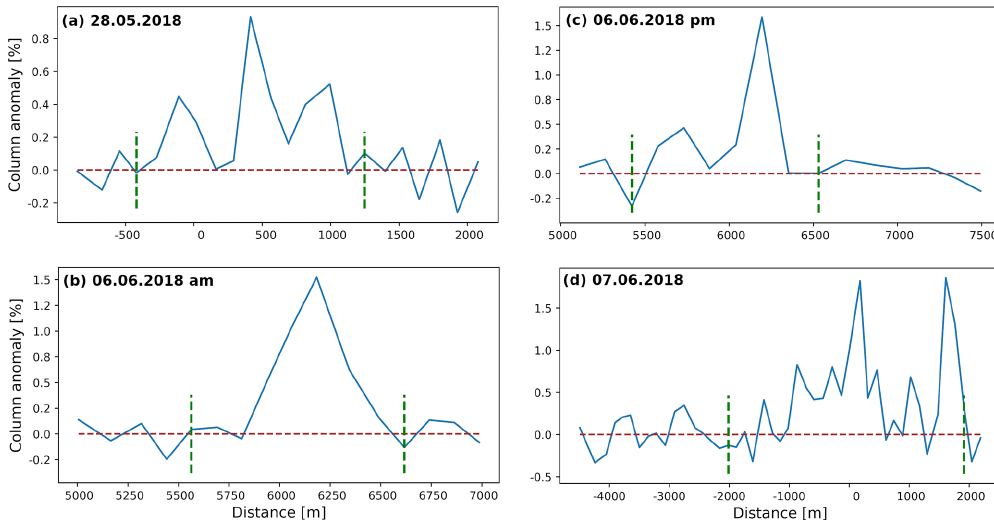
Figure C3. Same as Fig. C1 but for shaft cluster a. A 2D visualization is shown in Fig.